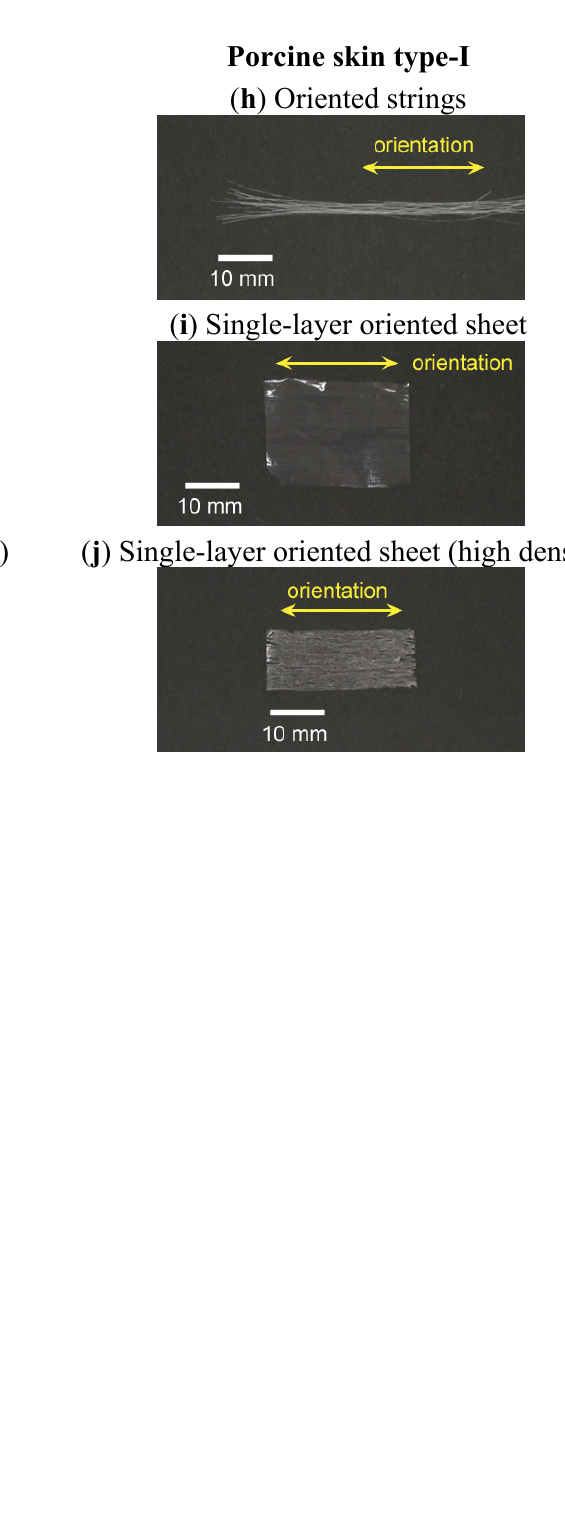
Figure 3. Various types of dehydrated oriented collagen scaffolds prepared with rat tail type-I and porcine skin type-I collagen